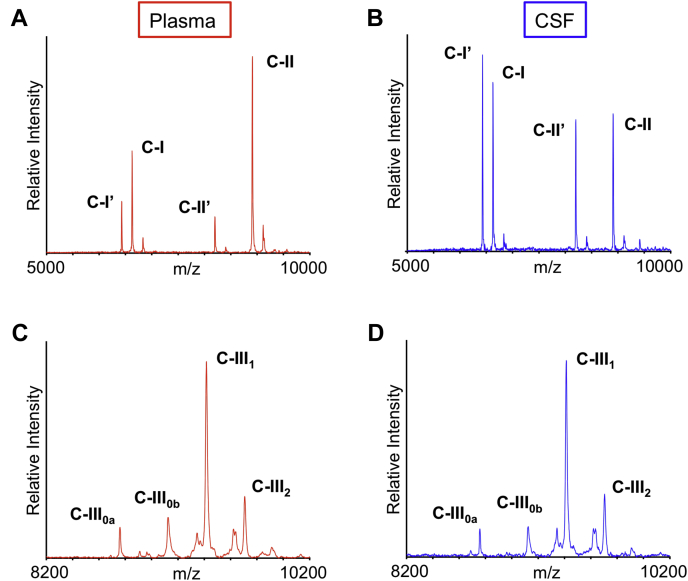
MALDI-TOF mass spectra for apoC-I and apoC-II resulting from the analysis of (A) plasma and (B) CSF paired samples obtained from a single individual. C-Iʹ, truncated apoC-I; C-IIʹ, truncated apoC-II. MALDI-TOF mass spectra for apoC-III resulting from the analysis of (C) plasma and (D) CSF paired samples obtained from the same individual. ApoC-III0a, no glycosylation; apoC-III0b, GalNac-Gal; apoC-III1, GalNac-Gal-Sia; apoC-III2, GalNac-Gal-Sia-Sia.